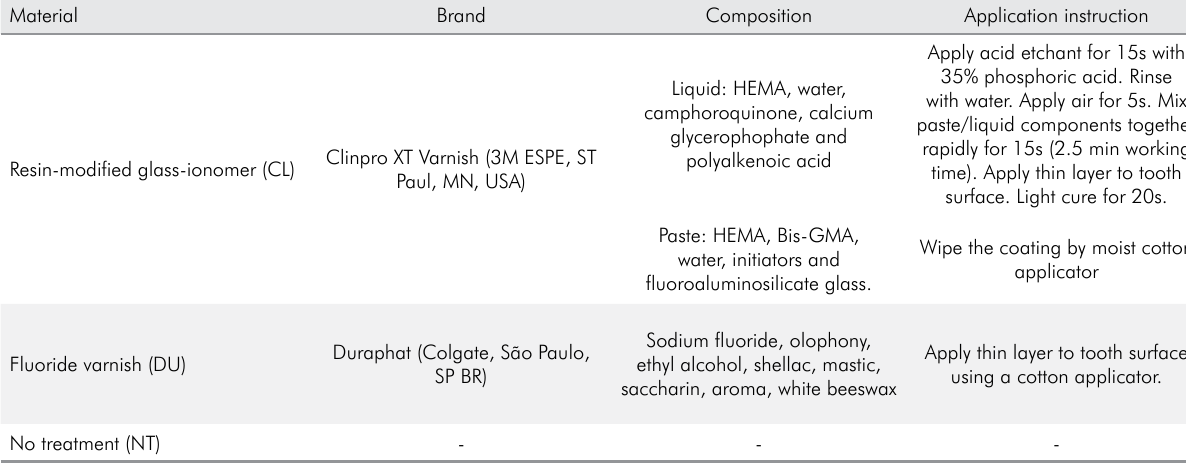
Table. Composition of the materials used in this study and instructions supplied by manufactures.